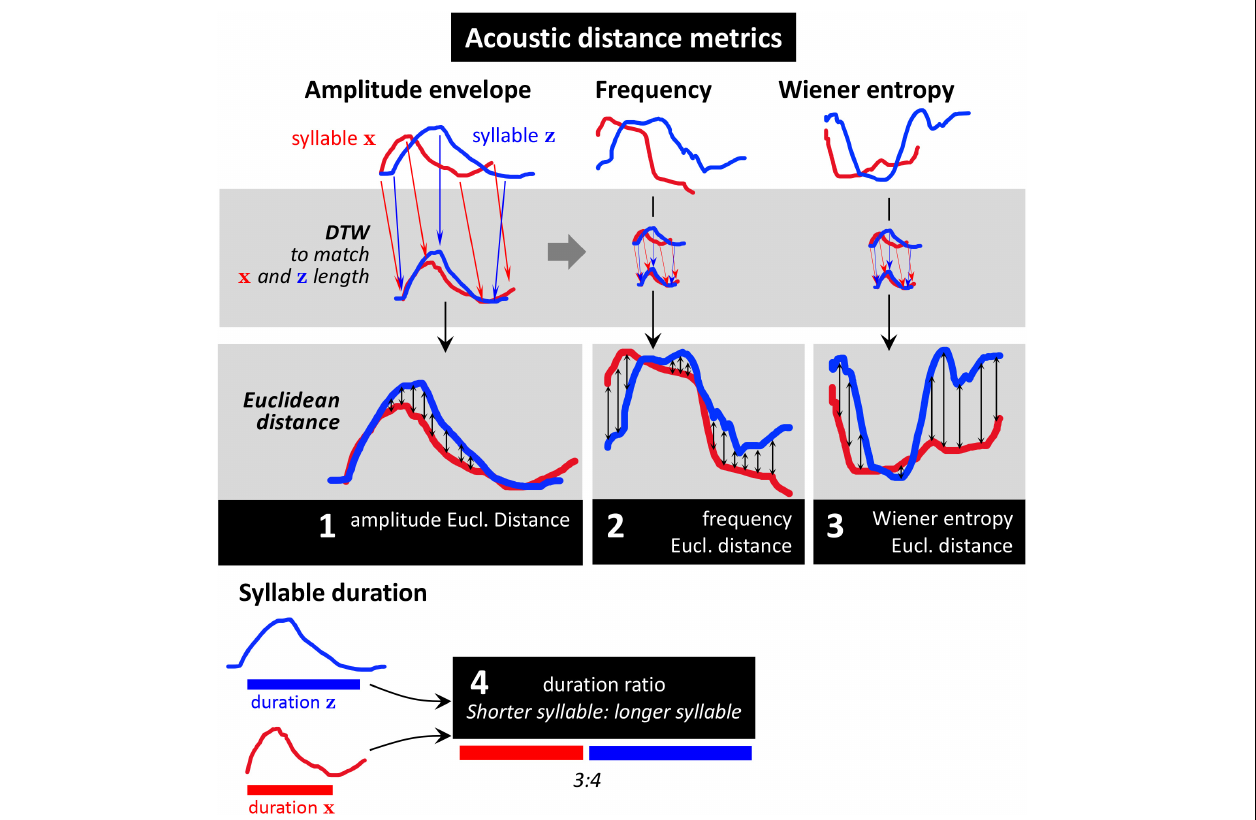
FIGURE 3 | Distance metrics used in this study. The distance metrics were designed to reflect the different kinds of acoustic syllable similarities/differences obtained from qualitative analysis. Acoustic features captured by our analysis are amplitude envelope, frequency (a measure of pitch), Wiener entropy (a measure of timbre), and syllable duration. We performed dynamic time warping (DTW) on the two syllables’ amplitude envelopes (upper gray panel), using the same warping path on amplitude, frequency, and entropy contours. Then we calculated mean Euclidean distance between the two syllables for each feature (bottom gray panels). To describe differences in syllable duration, we calculated their duration ratio (shorter syllable: longer syllable;